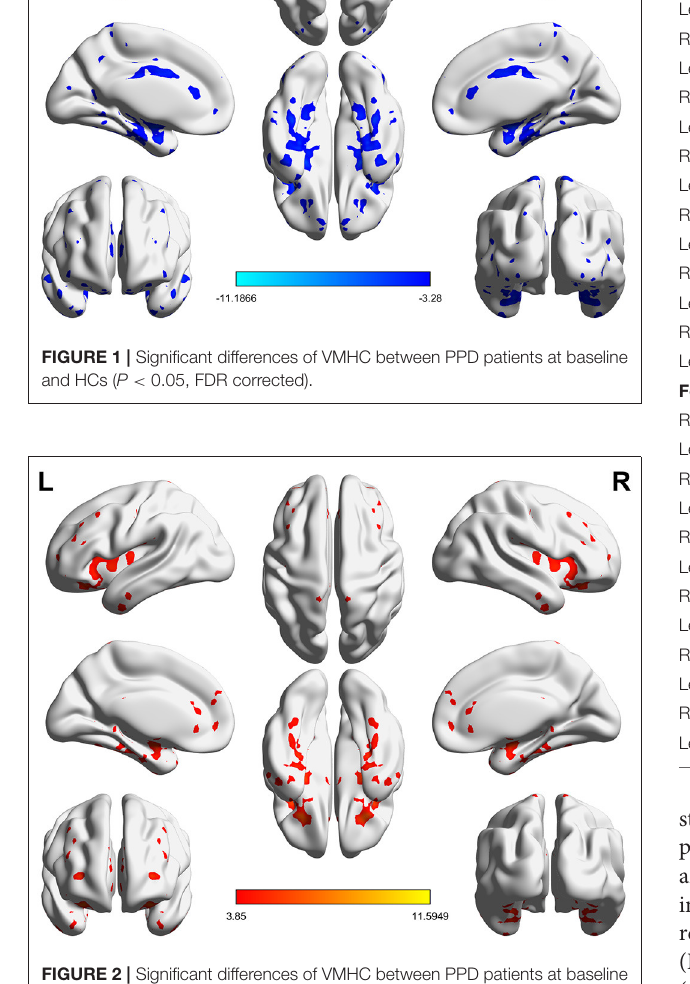
FIGURE 2 | Significant differences of VMHC between PPD patients at baseline and PPD patients at follow-up ( P < 0.05, FDR corrected).